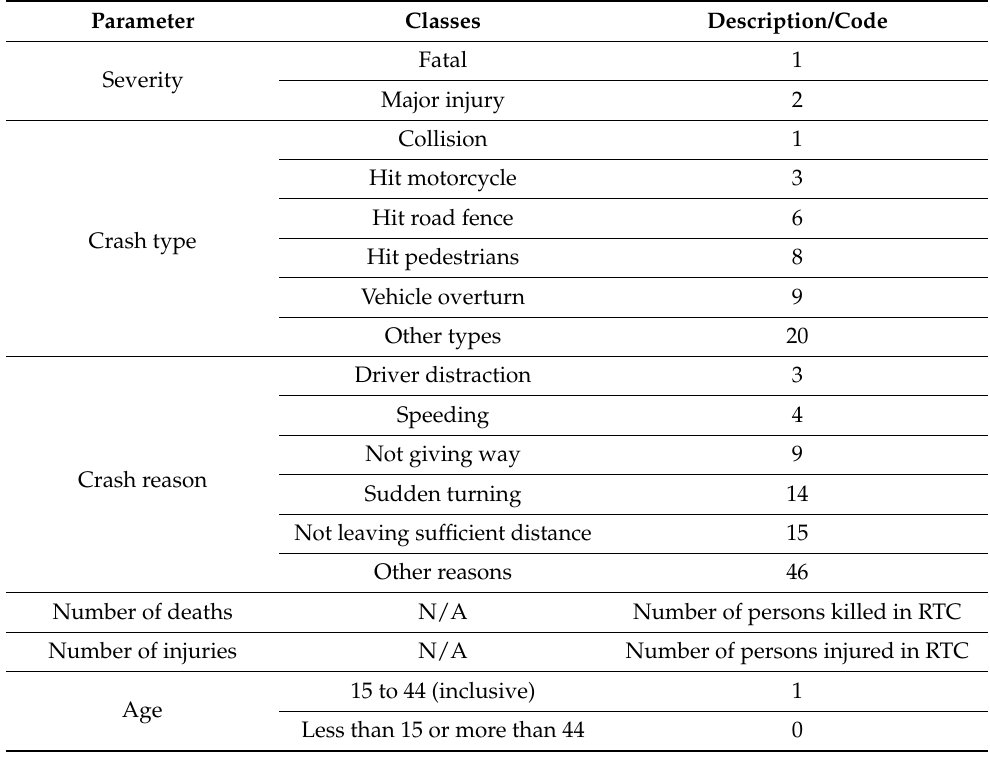
Table 4. Description of modeling